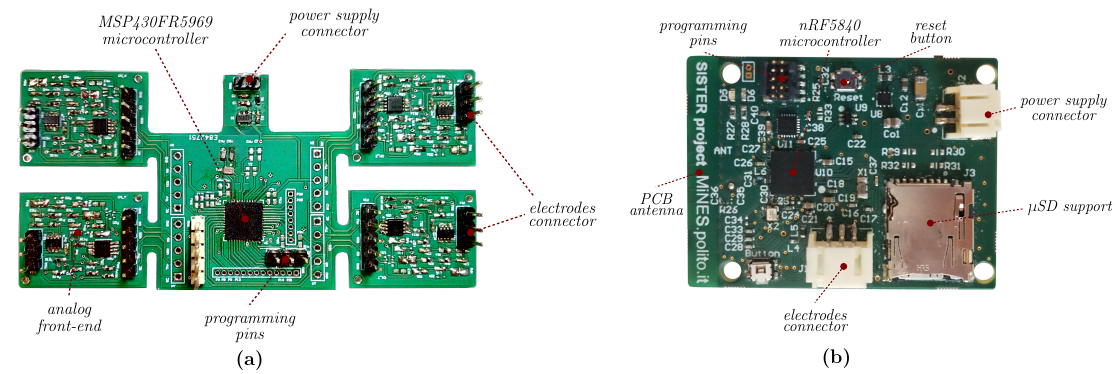
Figure 2. Custom sEMG acquisition device: ( a ) Four-channels board for multiple muscles monitoring, ( b ) independent single-channel